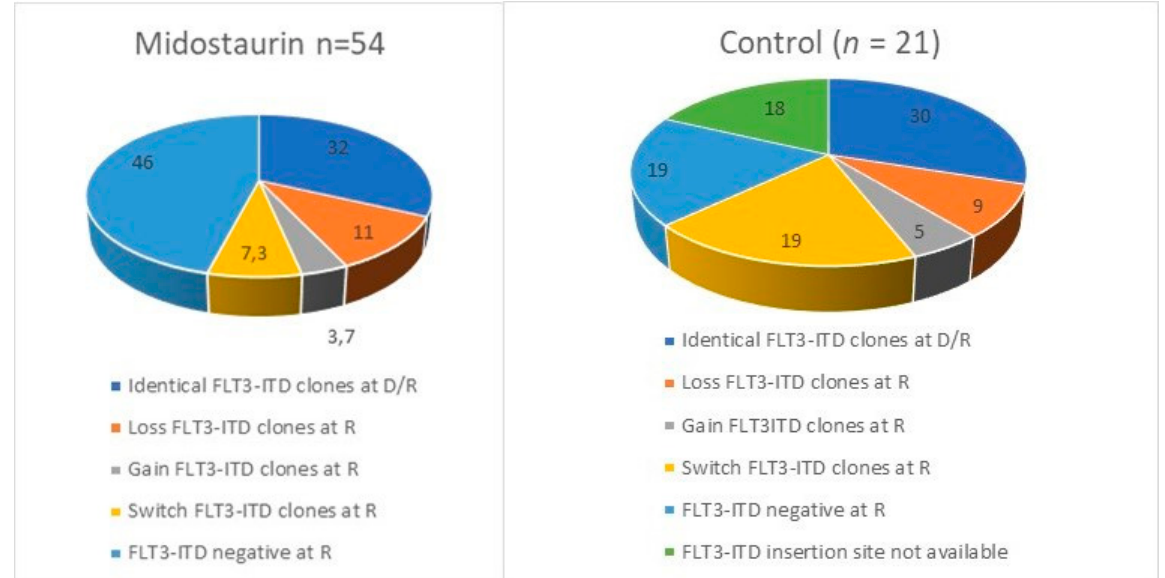
Figure 5. Distribution of FLT3 mutations at relapse or progression in RATIFY trial [34]. D/R: diagnosis/relapse or progression; R: relapse or progression.